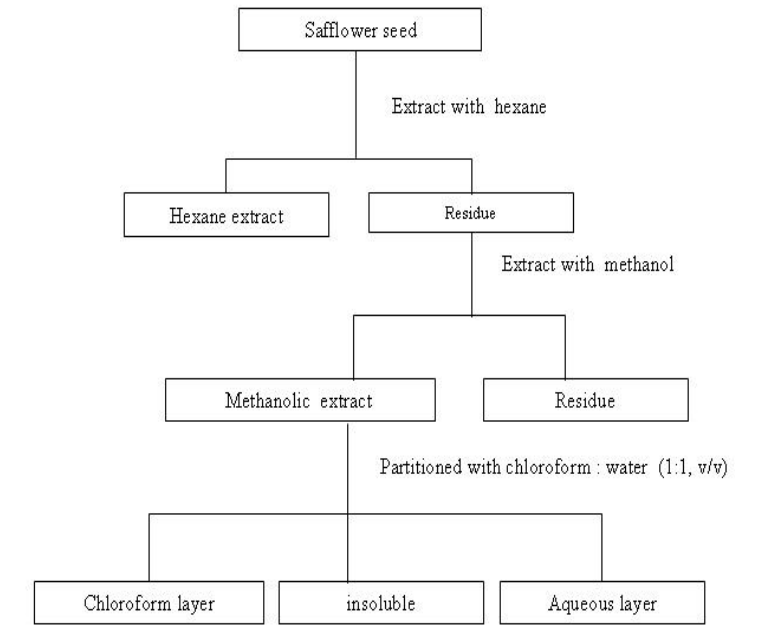
Figure 4. Flow chart showing the methanolic extraction from safflower